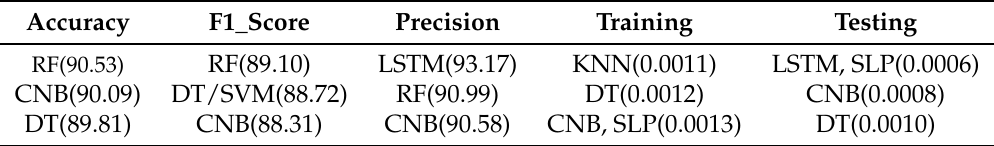
Table 4. The best algorithms according to different